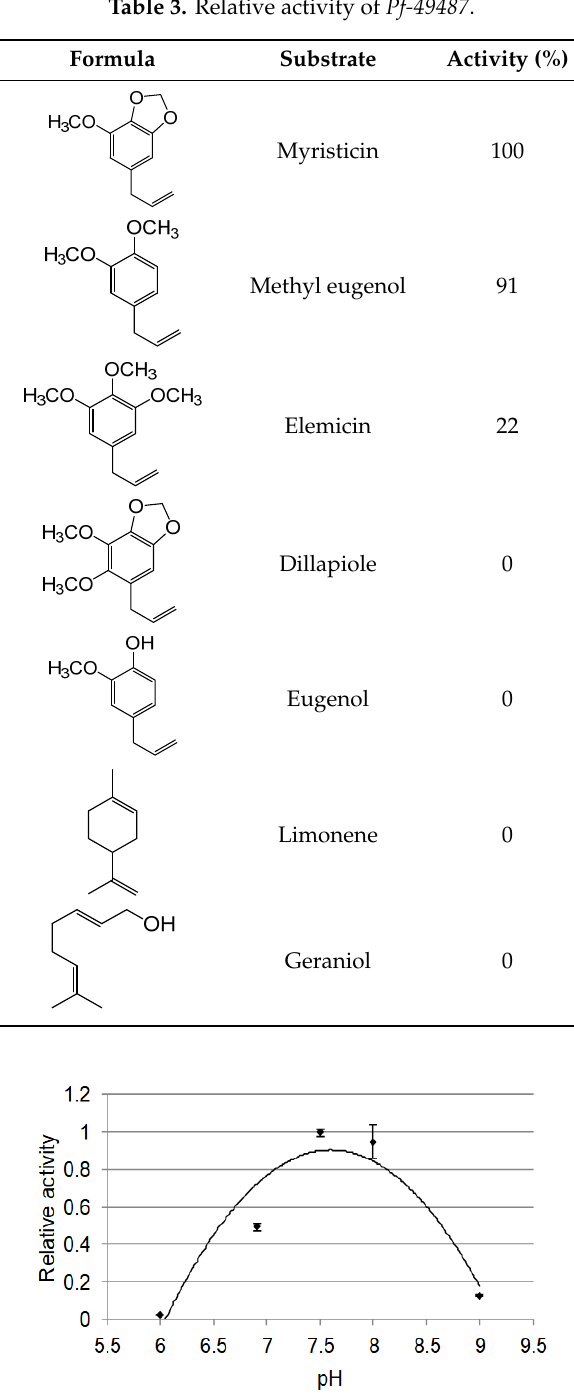
Table 3. Relative activity of Pf-49487 .